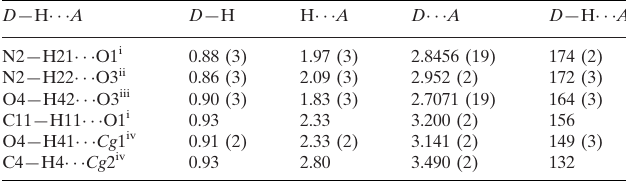
Hydrogen-bond geometry (A˚ , (cid:2)